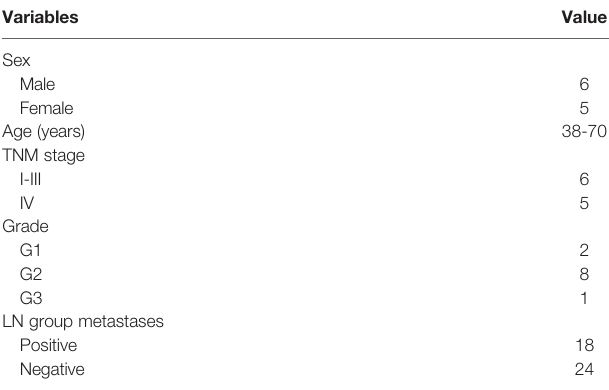
TABLE 2 | General characteristics of patients who underwent region LN dissection.